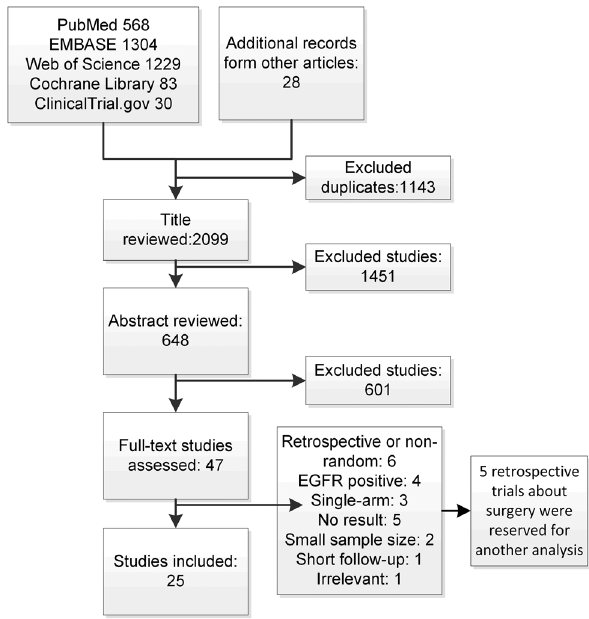
Figure 1: Flowchart of study selection. A total of 25 randomized controlled trials that met the inclusion criteria were included in the